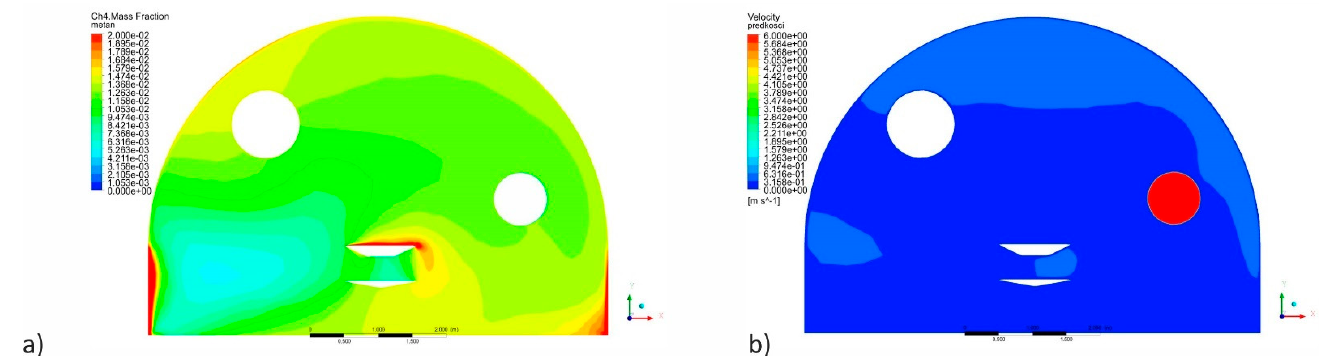
Figure 14. Cross ‐ section of roadway at the distance of 39 m to the face for the case L o = 20 m, ( a ) methane concentration field, ( b ) air velocity field.